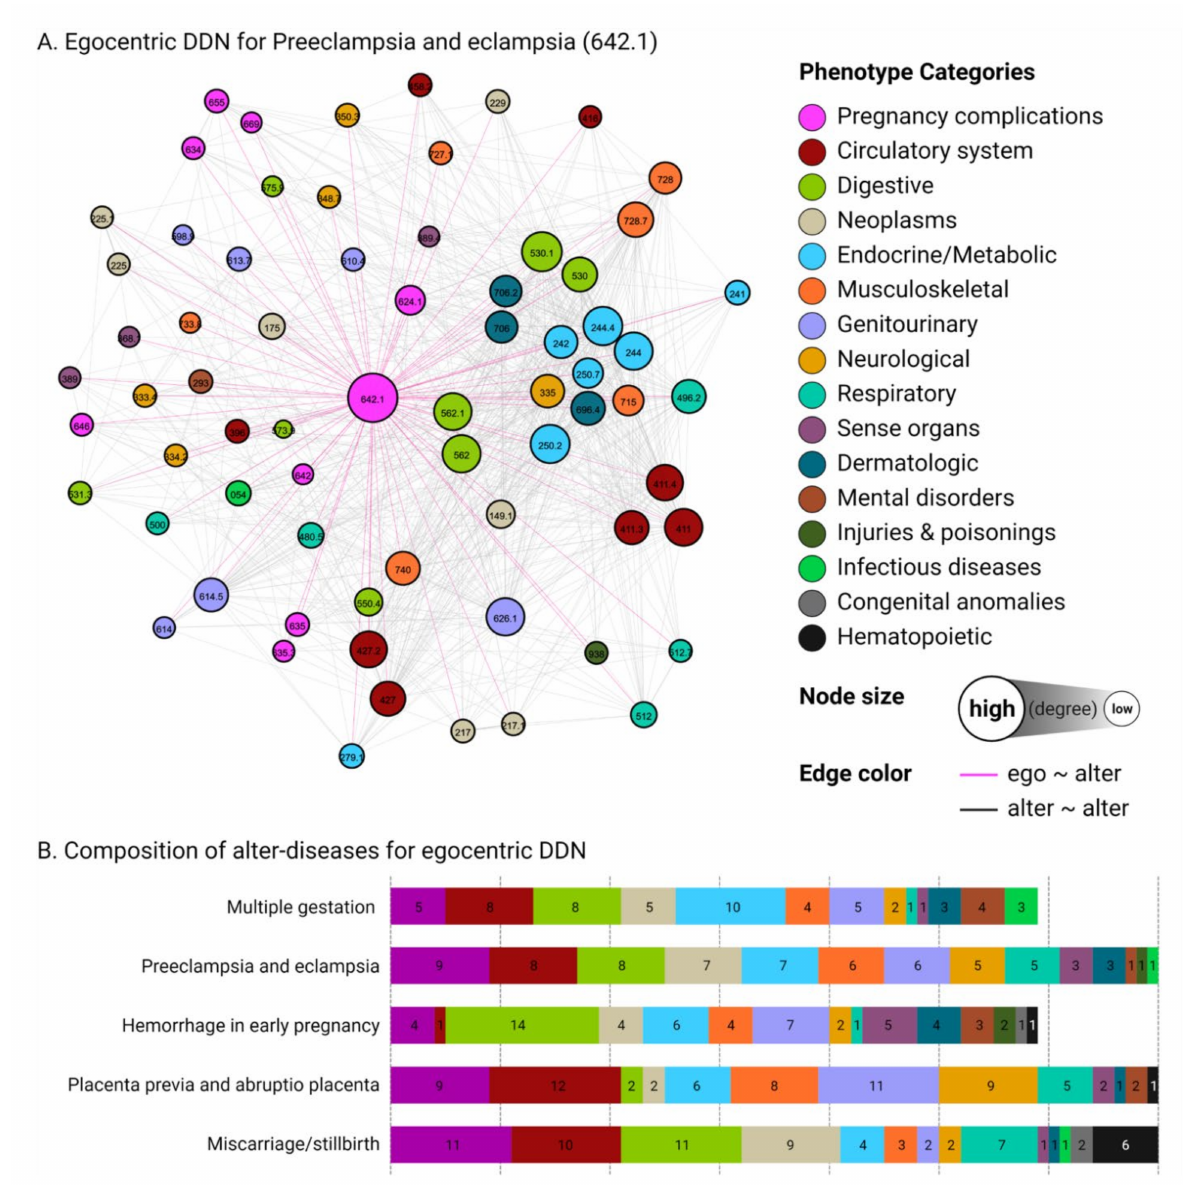
Figure 2. A depiction of ObstetricNet (preeclampsia and eclampsia). ( A ) A visualization of the egocentric network for ObstetricNet (preeclampsia and eclampsia). Nodes are sized by degree and colored by disease category. ( B ) A breakdown of disease categories for the five examples of obstetric disorders under consideration, indicating a wide variety of potential genetic associations between